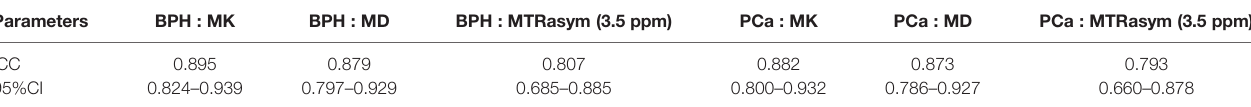
TABLE 3 | Interobserver agreement for each parameter of PCa and